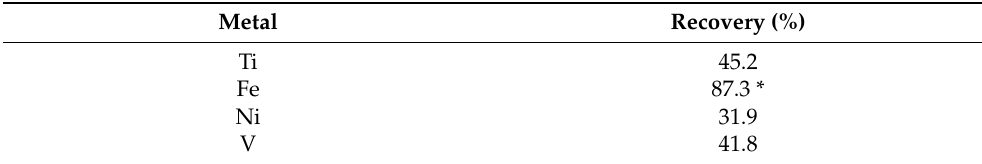
Table 4. Results on extraction of metals from magnetic